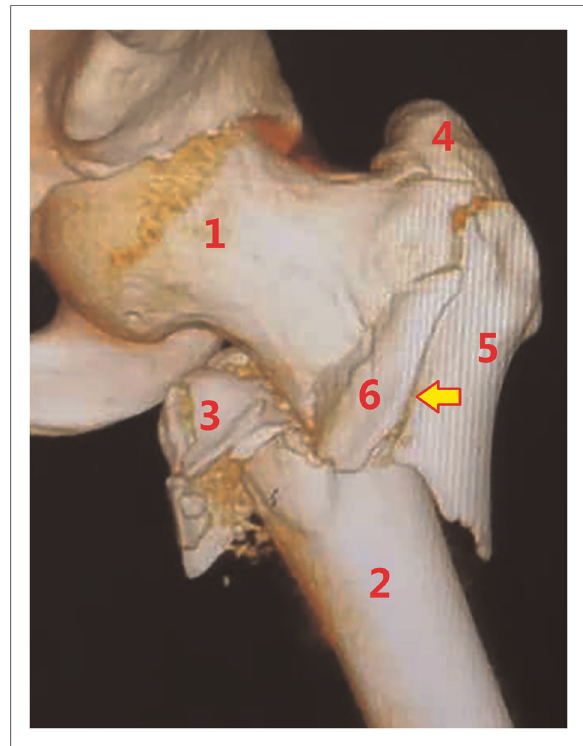
FIGURE 12 Subtype A4.1, with further comminution of the extracapsular anteromedial cortex. (1) Head – neck fragment, (2) femoral shaft, (3) lesser trochanter, (4) greater trochanter, (5) lateral cortex, and (6) anterior wall